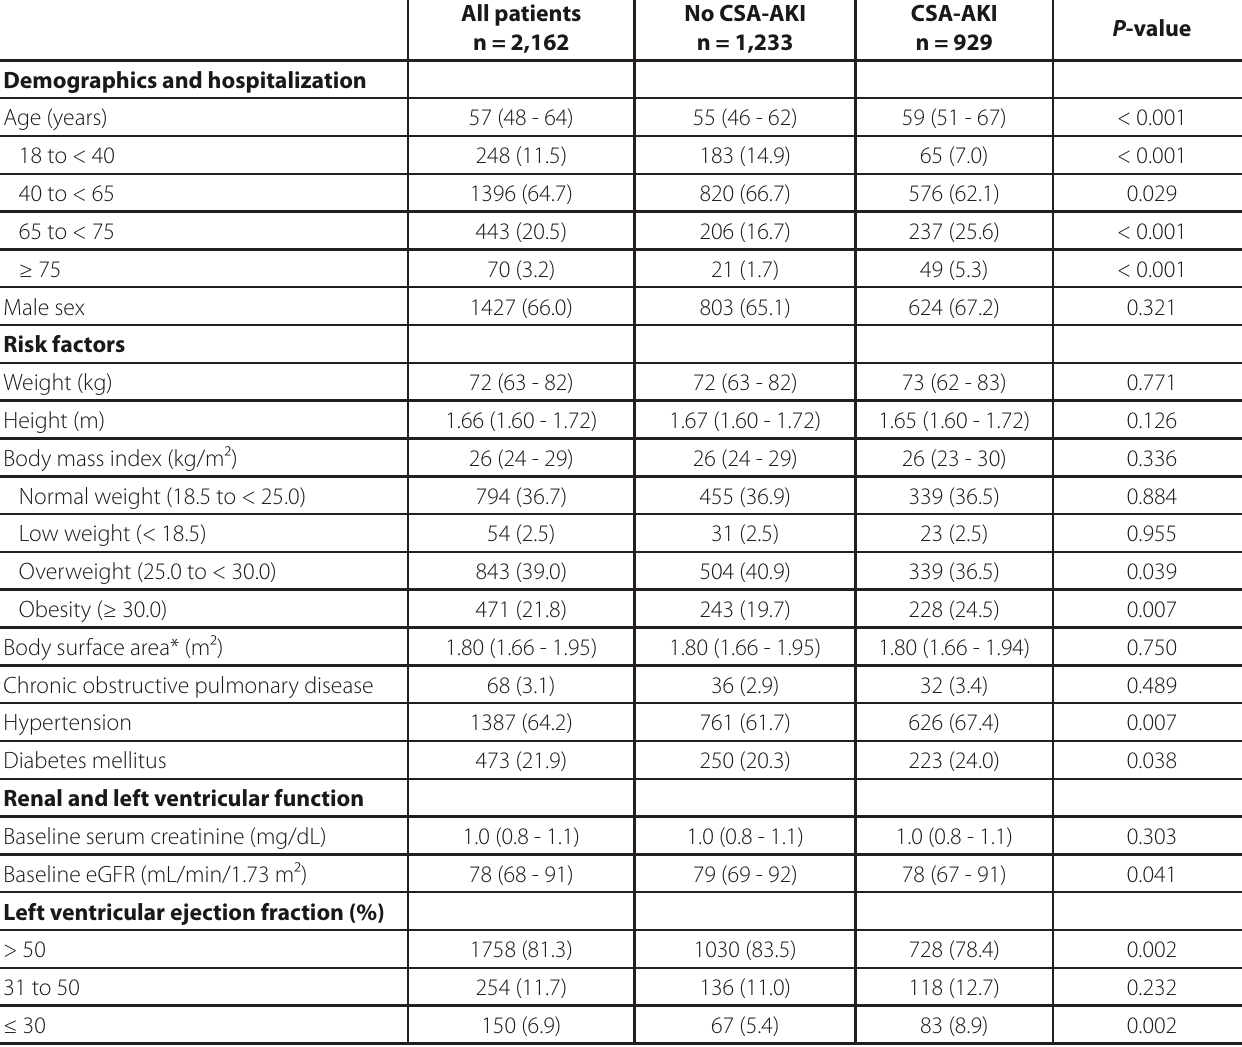
Table 1. Baseline characteristics and renal and left ventricular function of the 2,162 patients according to the development of CSA-AKI based on KDIGO